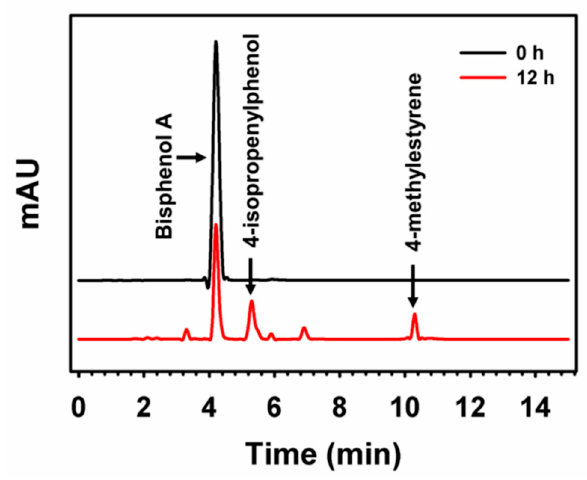
Figure 6. Analysis of degradation of bisphenol A by hNFs, as monitored by HPLC Reprinted from [142] with permission from the American Chemical Society. Copyright © 2021 American Chemical Society. Table 4. Examples of different enzymes immobilized on hNFs for water remediation.